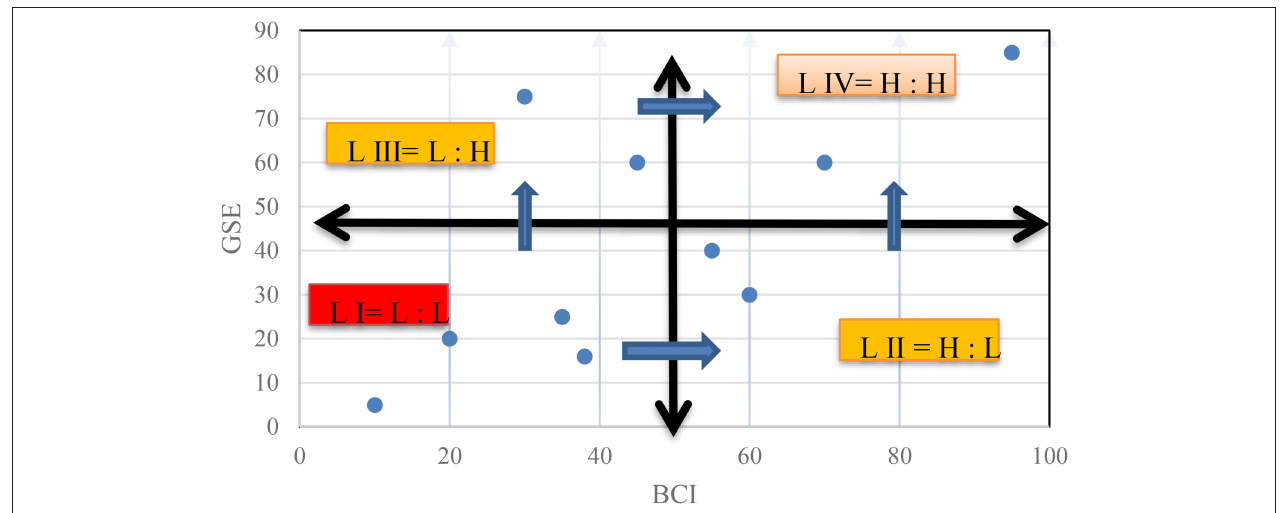
FIGURE 3 | A hypothetical ladder for monitoring effective wastewater reuse globally. Q 1 ... 4 , Quadrant; L, Low; H, High; Arrows indicate direction of